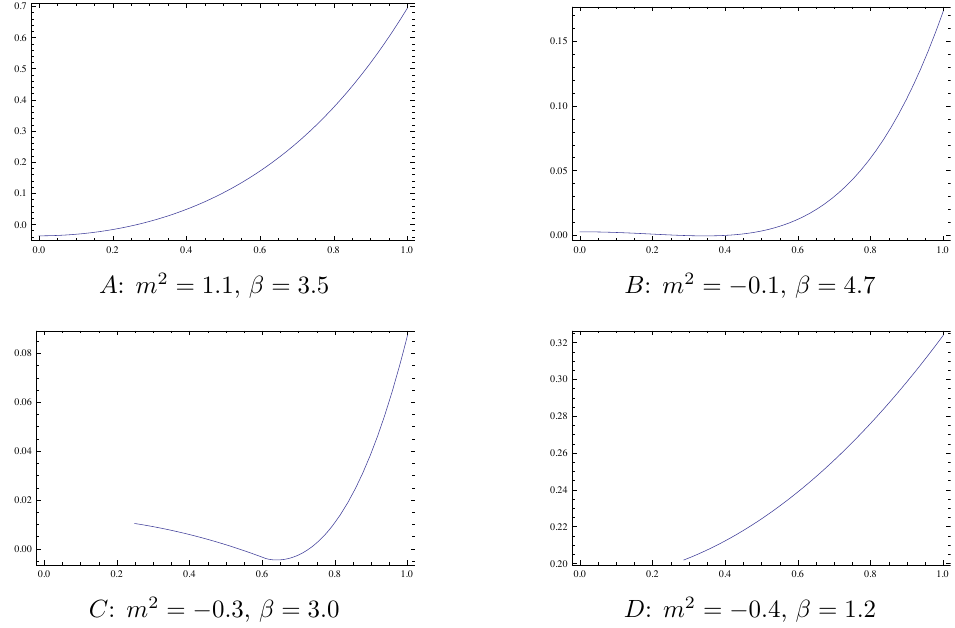
Figure 9. Representative plots of the potential corresponding to the regions in figure 8(a) for λ = 0 . 5